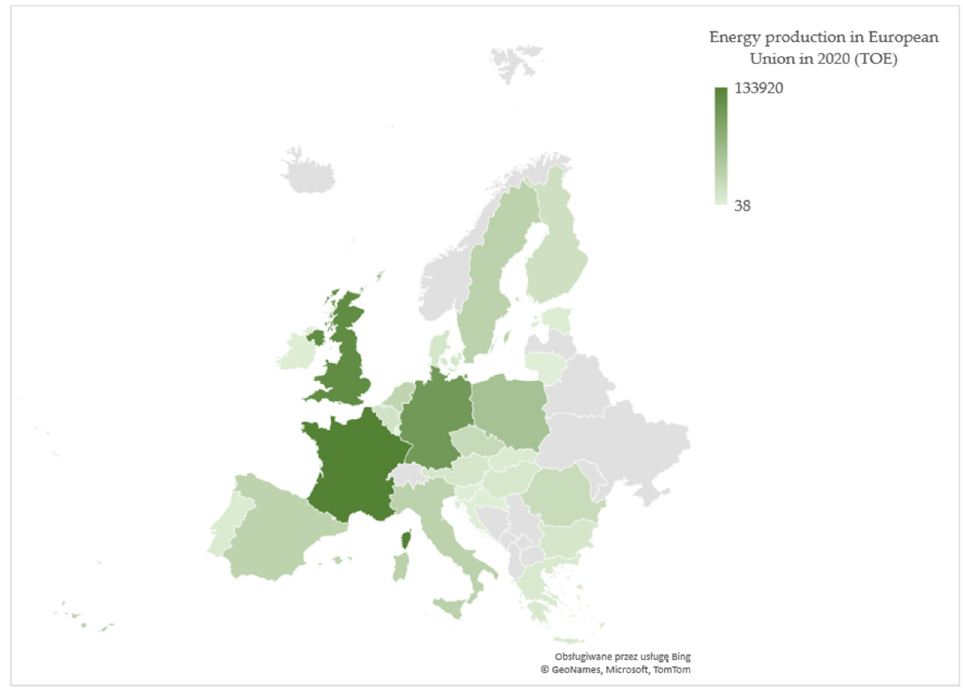
Figure 4. Energy production in European Union countries in 2020 (TOE). Source: own elaborations based on [43].